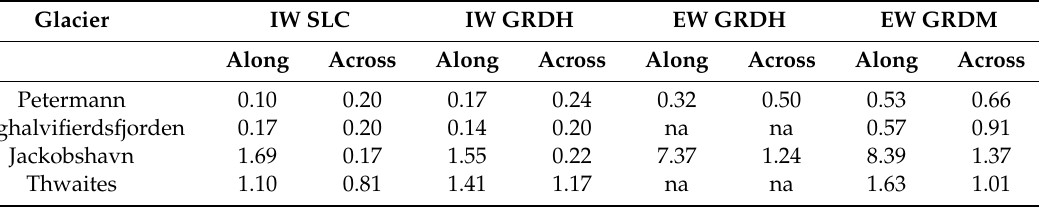
Table 12. RMSE (expressed in m / day) against reference literature for the selected along / across flow transects for the four analyzed glaciers and product classes calculated by averaging one year of observations.